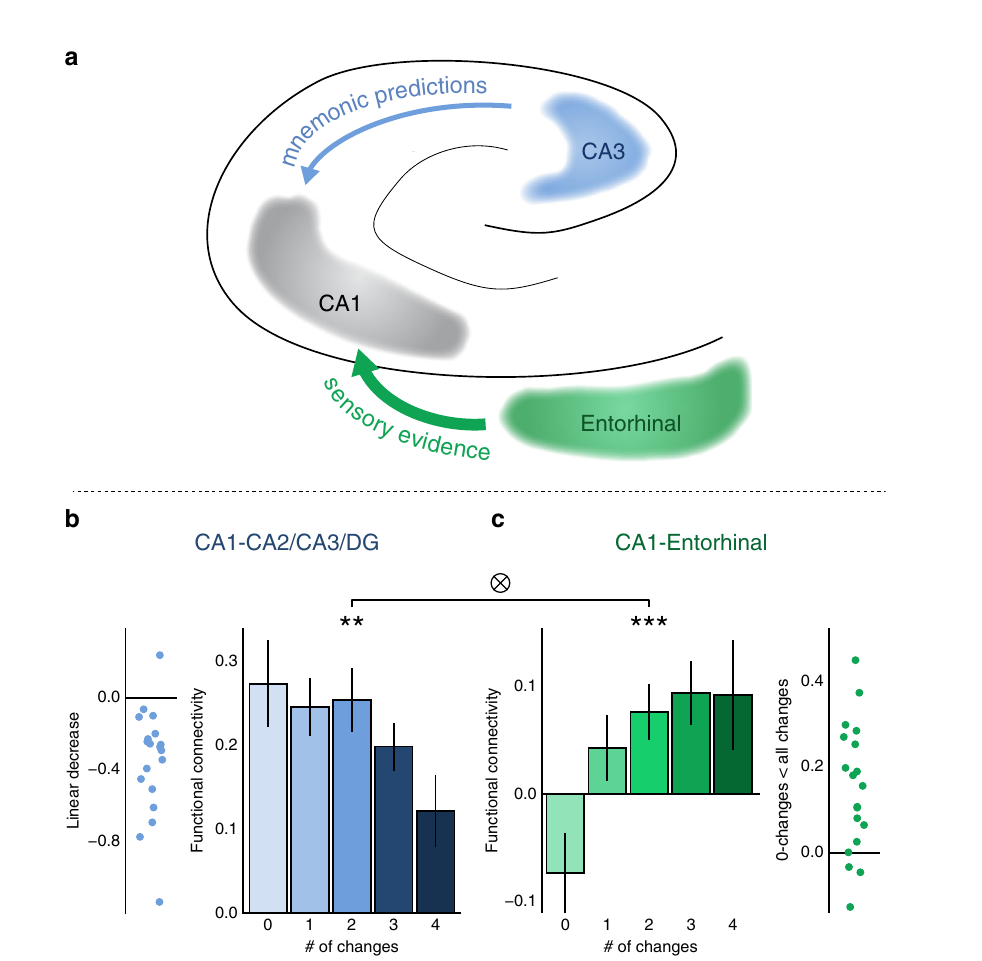
Fig. 2 Functional connectivity with region CA1. a Mnemonic prediction errors decreased CA1 – CA3 interaction, while increasing CA1 – entorhinal cortex interaction, potentially re fl ecting reduced processing of erroneous predictions, and upregulating processing of sensory evidence. b Functional connectivity of CA1 with region CA2/CA3/DG (blue). Dots in the dots plot re fl ect individual participants ’ linear decrease contrast score, computed across all number of changes (the preferable contrast in this pair of regions, main text). c Functional connectivity of CA1 with entorhinal cortex (green). Dots in the dots plot re fl ect individual participants ’ 0-changes (match) < average of 1 – 4 changes (mismatch; the preferable contrast in this pair of regions, main text). # of changes: number of changes. F-transformed beta-series correlation was our measure of functional connectivity. Data are from the left hemisphere (see main text). N = 19. Data in the bar graphs are presented as mean values, error bars re fl ect + / − SEM. ⊗ Interaction of # of changes by ROI in a repeated- measures ANOVA: P = 0.0003. ** P = 0.01, *** P = 0.003, the results of a one-way repeated-measures ANOVA within each pair of ROIs. Source data